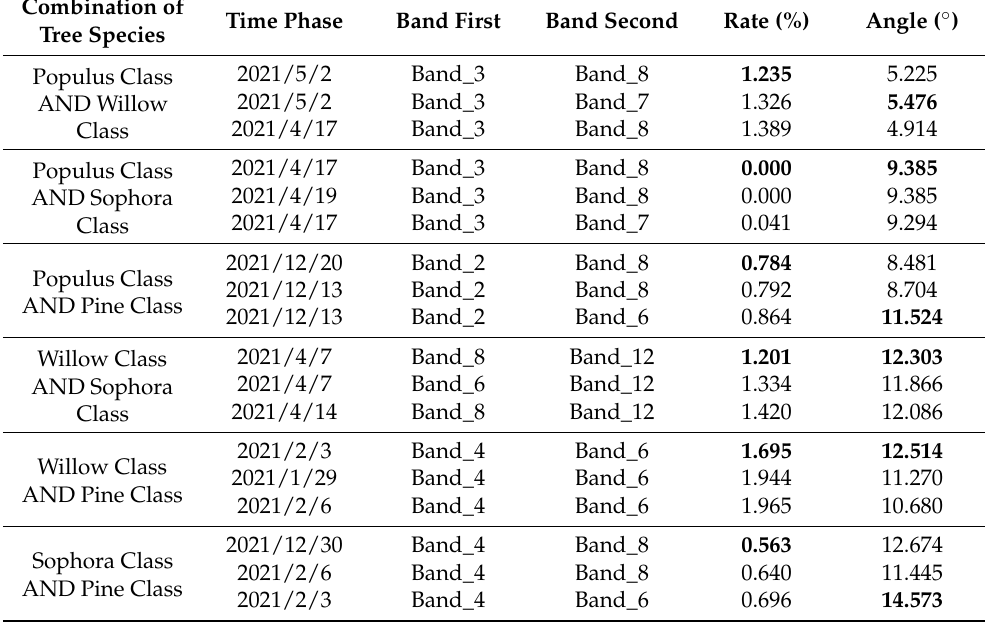
Table 3. Table of ASDER values for various